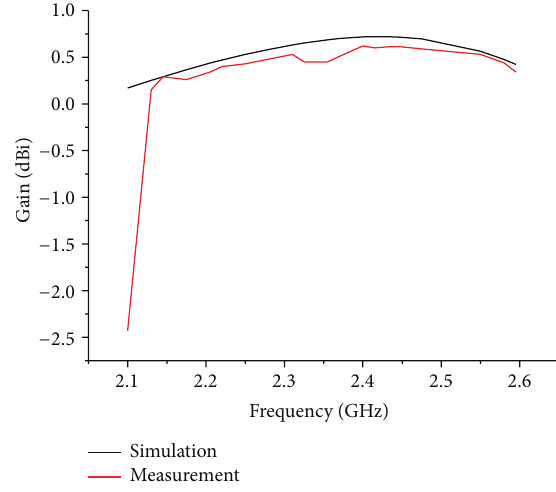
Figure 12: Gain of MIMO antenna